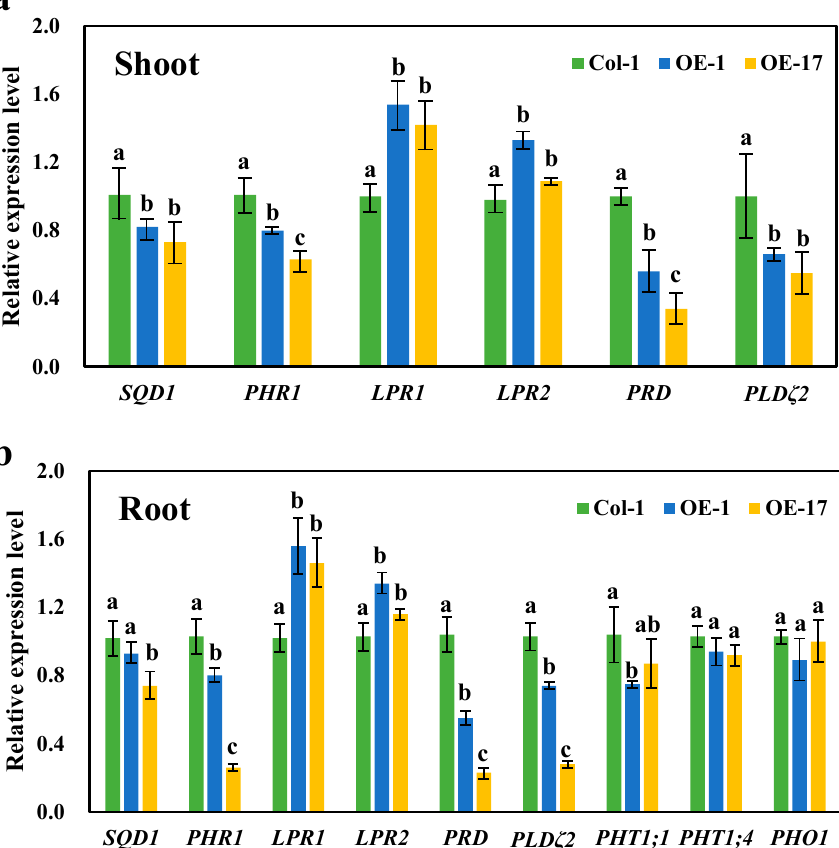
Figure 9. Relative expression levels of the Pi starvation-responsive genes in the wild-type (Col-0) and overexpression BnaA7.CRF8 lines. Shoots ( a ) and roots ( b ) of the 11-day-old plants grown on 1000 µ M Pi were used to perform qRT-PCR analyses. Data represent mean ± SD of 3 biological replicates with 20 plants each. Different letters (a, b, and c) indicate mean with significant differences at p < 0.05 by Duncan’s test. LPR1 / 2 , LOW PHOSPHATE ROOT1 / 2 ; PHO1 , PHOSPHATE1 ; PHR1 , PHOSPHATE STARVATION RESPONSE1 ; PHT , PHOSPHATE TRANSPORTER ; PRD , PHOSPHATE ROOT DEVELOPMENT; PLD ζ 2 encodes an enzyme in phosphatidylcholine hydrolysis; SQD1 encodes an enzyme in sulfolipid biosynthesis. Table 1. The molecular functions of the genes analyzed in this study.